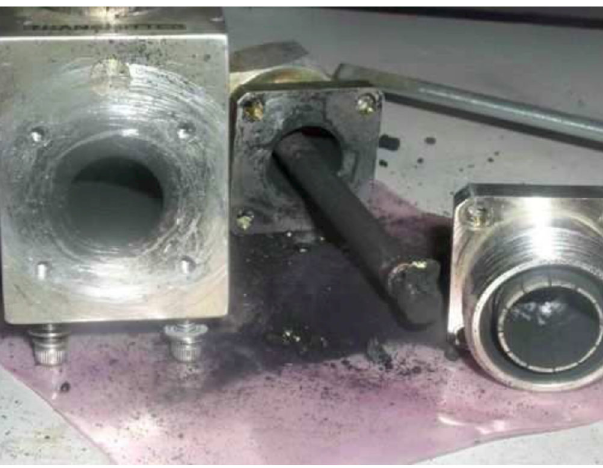
17. (Color) Photo of a damaged high-power directional coupler installed on the PEP-II beam line to instrument beam- driven kicker power. While designed to operate at 5 KW power levels, the kicker loads, cables, and feedthroughs were problem- atic in operation. Three different styles of high-power rf con- nectors were commissioned in the PEP-II runs, each had high- power difficulties. The beam induced power was spread in a very broad band extending to 20 GHz. Seen in the figure is a damaged and destroyed 9 = 16 DIN connector and directional coupler